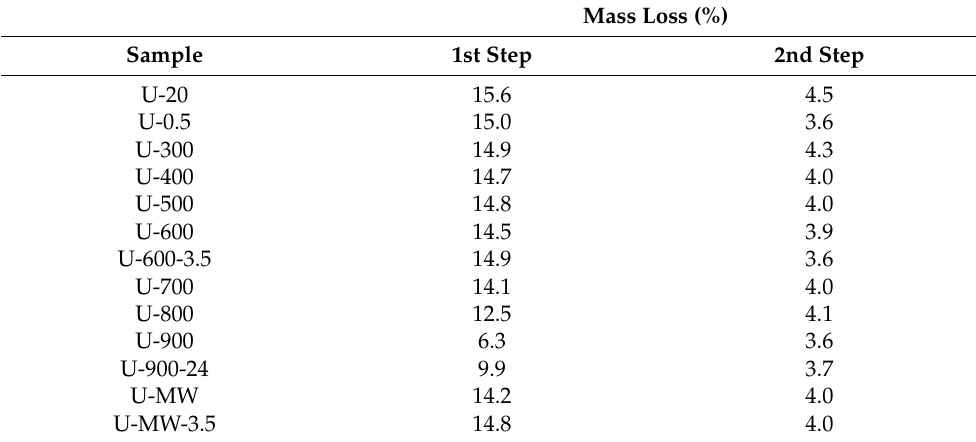
Figure 6. Temperature dependence of the mass loss, TG-curve, for Ugandan samples: pristine, heat- treated and microwave-irradiated. In the inset, temperature dependence of the mass loss, TG-curve, for Ugandan samples: pristine and heat-treated (600 °C and 900 °C) and microwave-irradiated and their counterparts after immersion in distilled water. Table 4. Mass loss (%) in the two